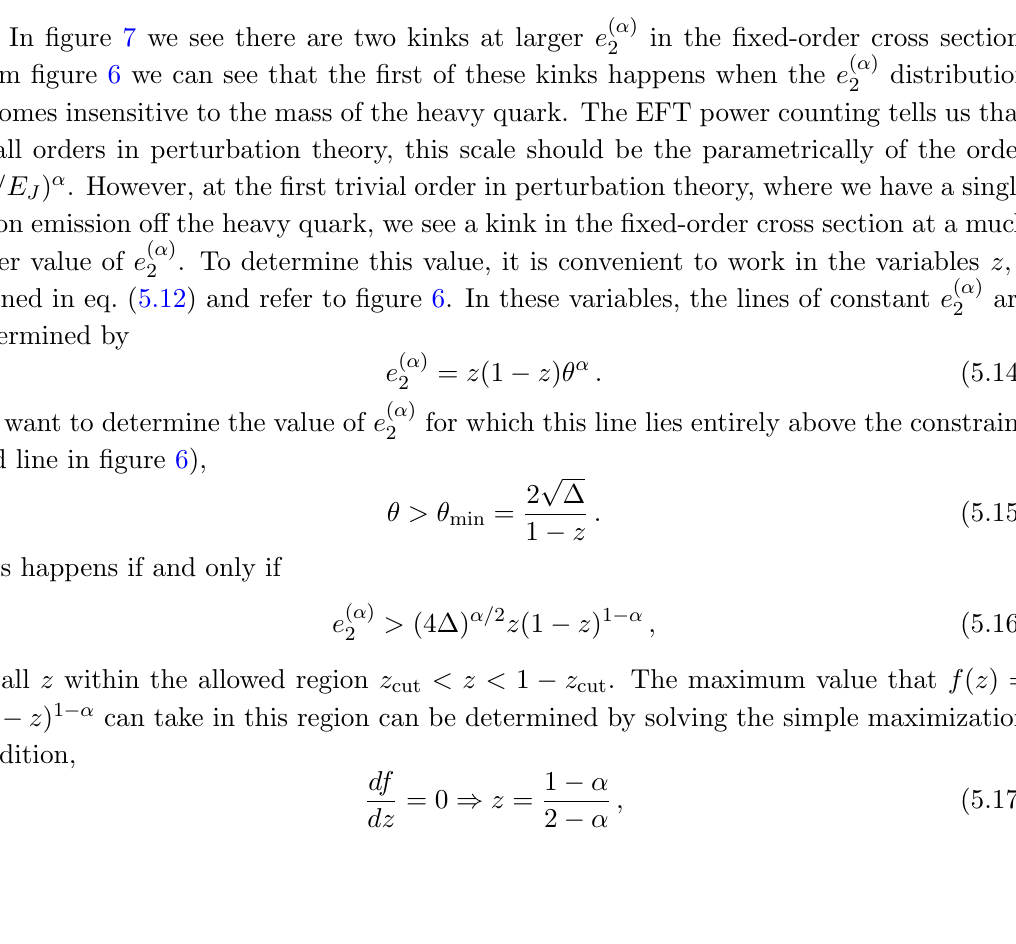
distribution. The massive full 2